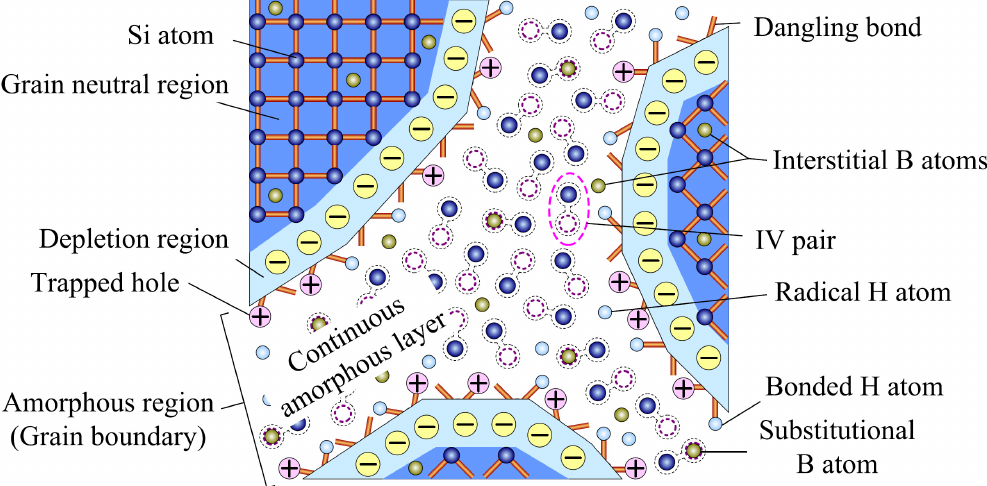
Figure 14. Interstitial-vacancy model of grain boundaries in